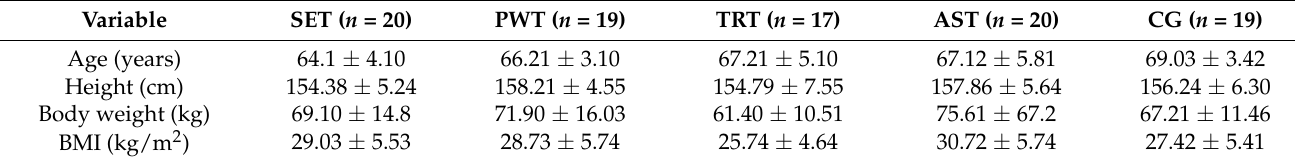
Table 1. Participants at baseline (mean ±